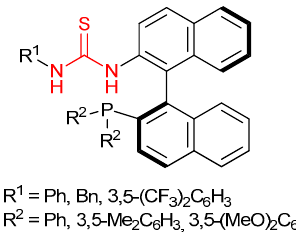
Figure 22. Axially chiral phosphine-containing thiourea [300].